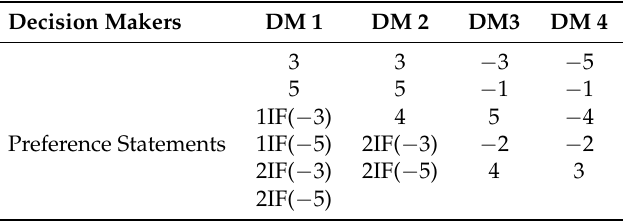
Table 5. Preferences statements for ranking